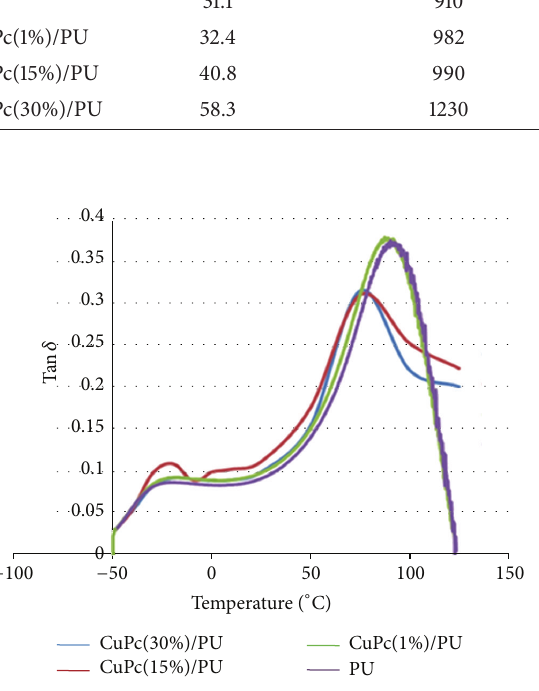
Figure 5: Temperature dependence of loss tangent (tan 𝛿 ) for the PU, CuPc(1%)/PU, CuPc(15%)/PU, and CuPc(30%)/PU